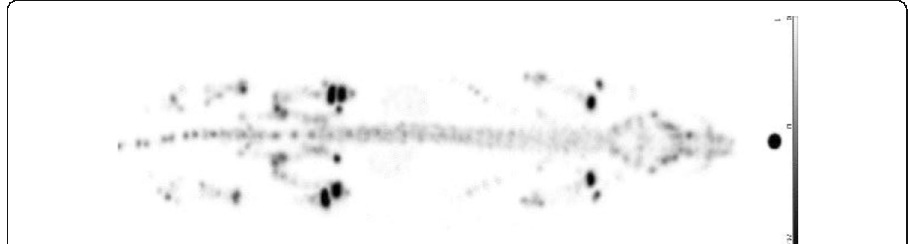
Fig. 5 Whole body scintigraphy 1 h after administration of [ 177 Lu]DOTA ZOL . The compound shows strong accumulation in the bone, and in particular in the high metabolic epiphyseal plates and other joint regions (the same effect was observed for the 68